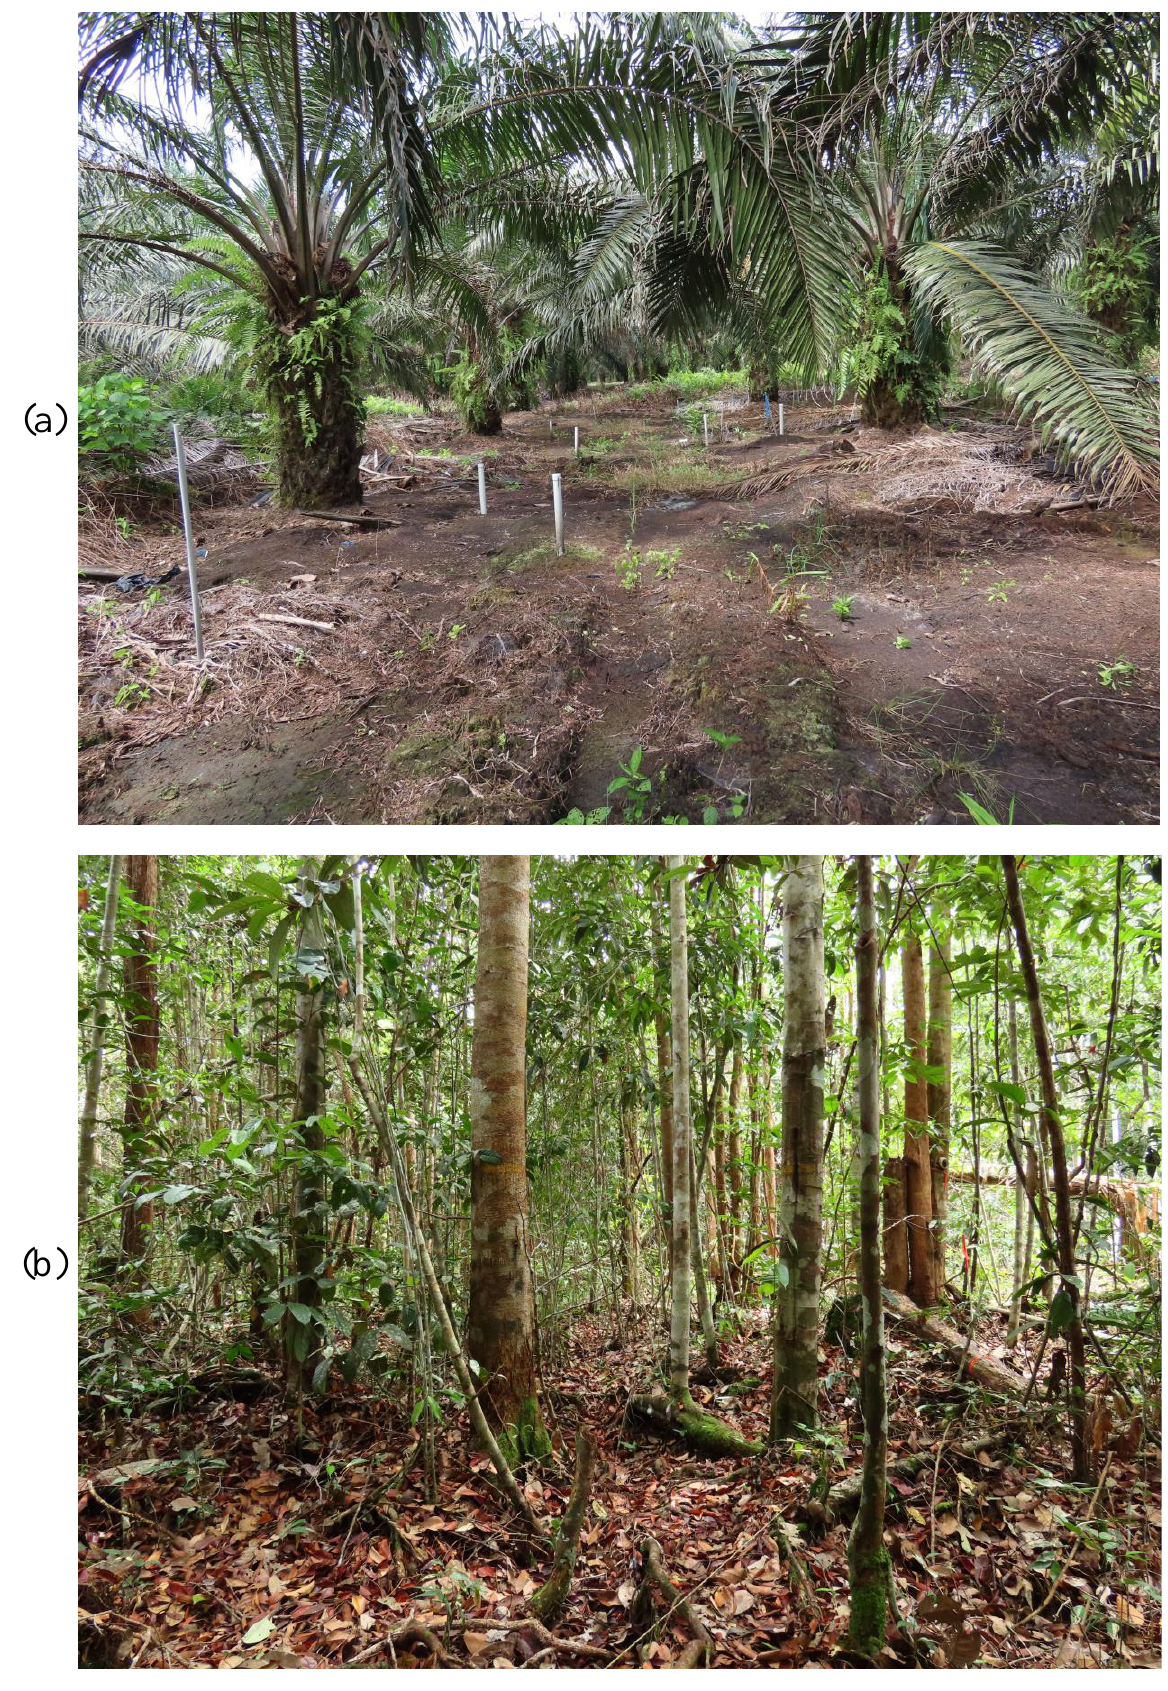
Figure 2. Photographs of vegetation in the study plots at (a) the Sebungan oil palm estate and (b) the Sabaju 4 secondary tropical